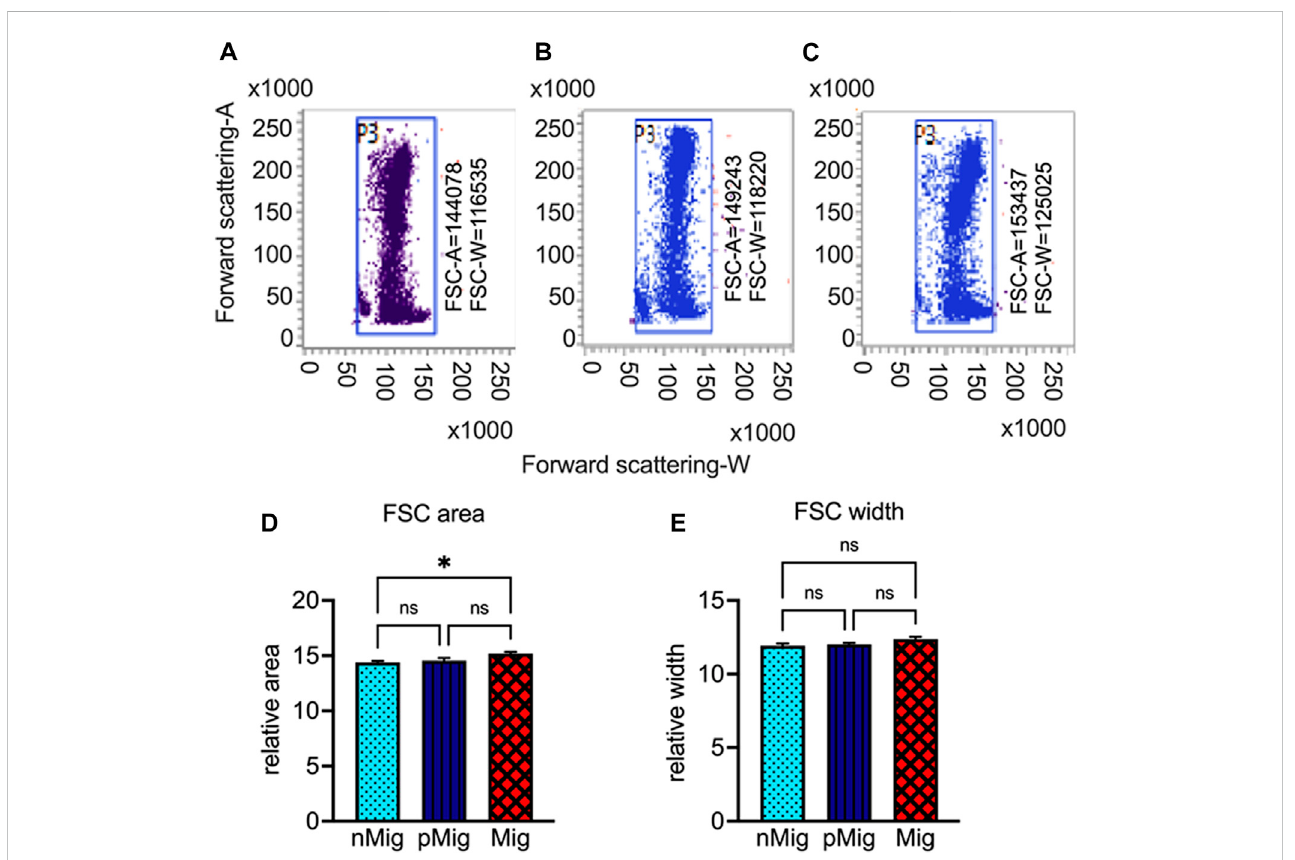
FIGURE 2 Changes in erythrocyte area and width during migration. Blood was collected from non-migratory ( nMig , cyan blue), pre-migratory ( pMig , blue), and migratory ( Mig , red) red-headed buntings ( n = 6) placed under SD/LD for 0, 7, and 28 days, and the mean area (forward scattering A) and width (forward scattering W) of erythrocytes were measured using fl ow cytometry. The dot-blots in Panel (A – C) show the FSC-A/FSC-W in non-migratory ( nMig , A), pre- migratory ( pMig , B), and migratory ( Mig , C) states, respectively. The bar graphs in panels (D,E) depict the cumulative changes in erythrocyte area and width, respectively. The values in dot-plots indicate the mean FSC-A and FSC-W at different states. Data in (D,E) are represented as mean ± SEM. Asterisk (*) over the line on the bar indicates a signi fi cant difference between nMig , pMig , and Mig states of buntings (* p < 0.05, Tukey ’ s